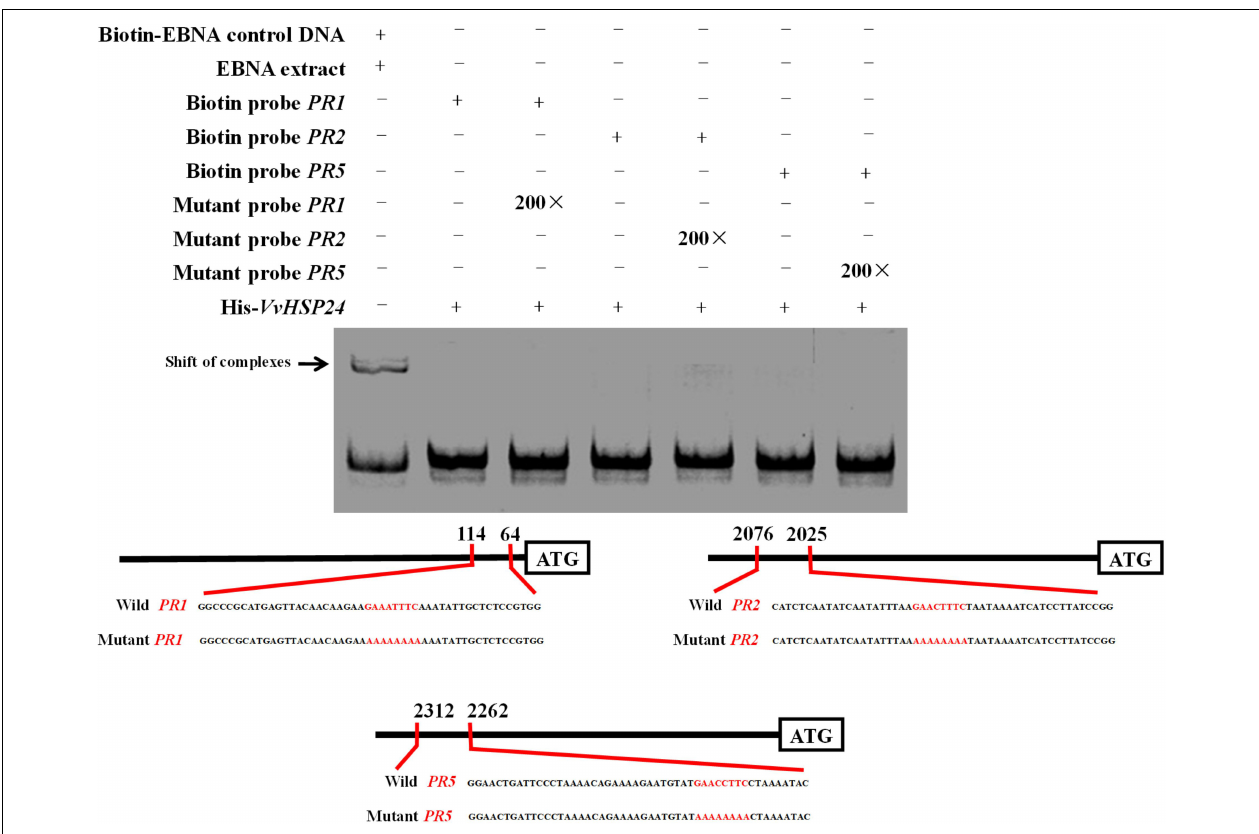
FIGURE 6 | The binding patterns of VvHSP24 to the promoters of PR1 -, PR2-, and PR5 -containing HSE motifs were detected by EMSA. The HSE elements within the probe sequences are highlighted with red letters. The recombinant His- VvHSP24 protein was incubated with biotin-labeled probes and then the protein-DNA complexes were resolved on polyacrylamide gels and visualized by exposure of the dehydrated gels to X-ray films. The addition of 200-fold mutant probes was performed in the competitive binding assays to test for the specific of the binding assays between VvHSP24 and PR1 , PR2, and PR5